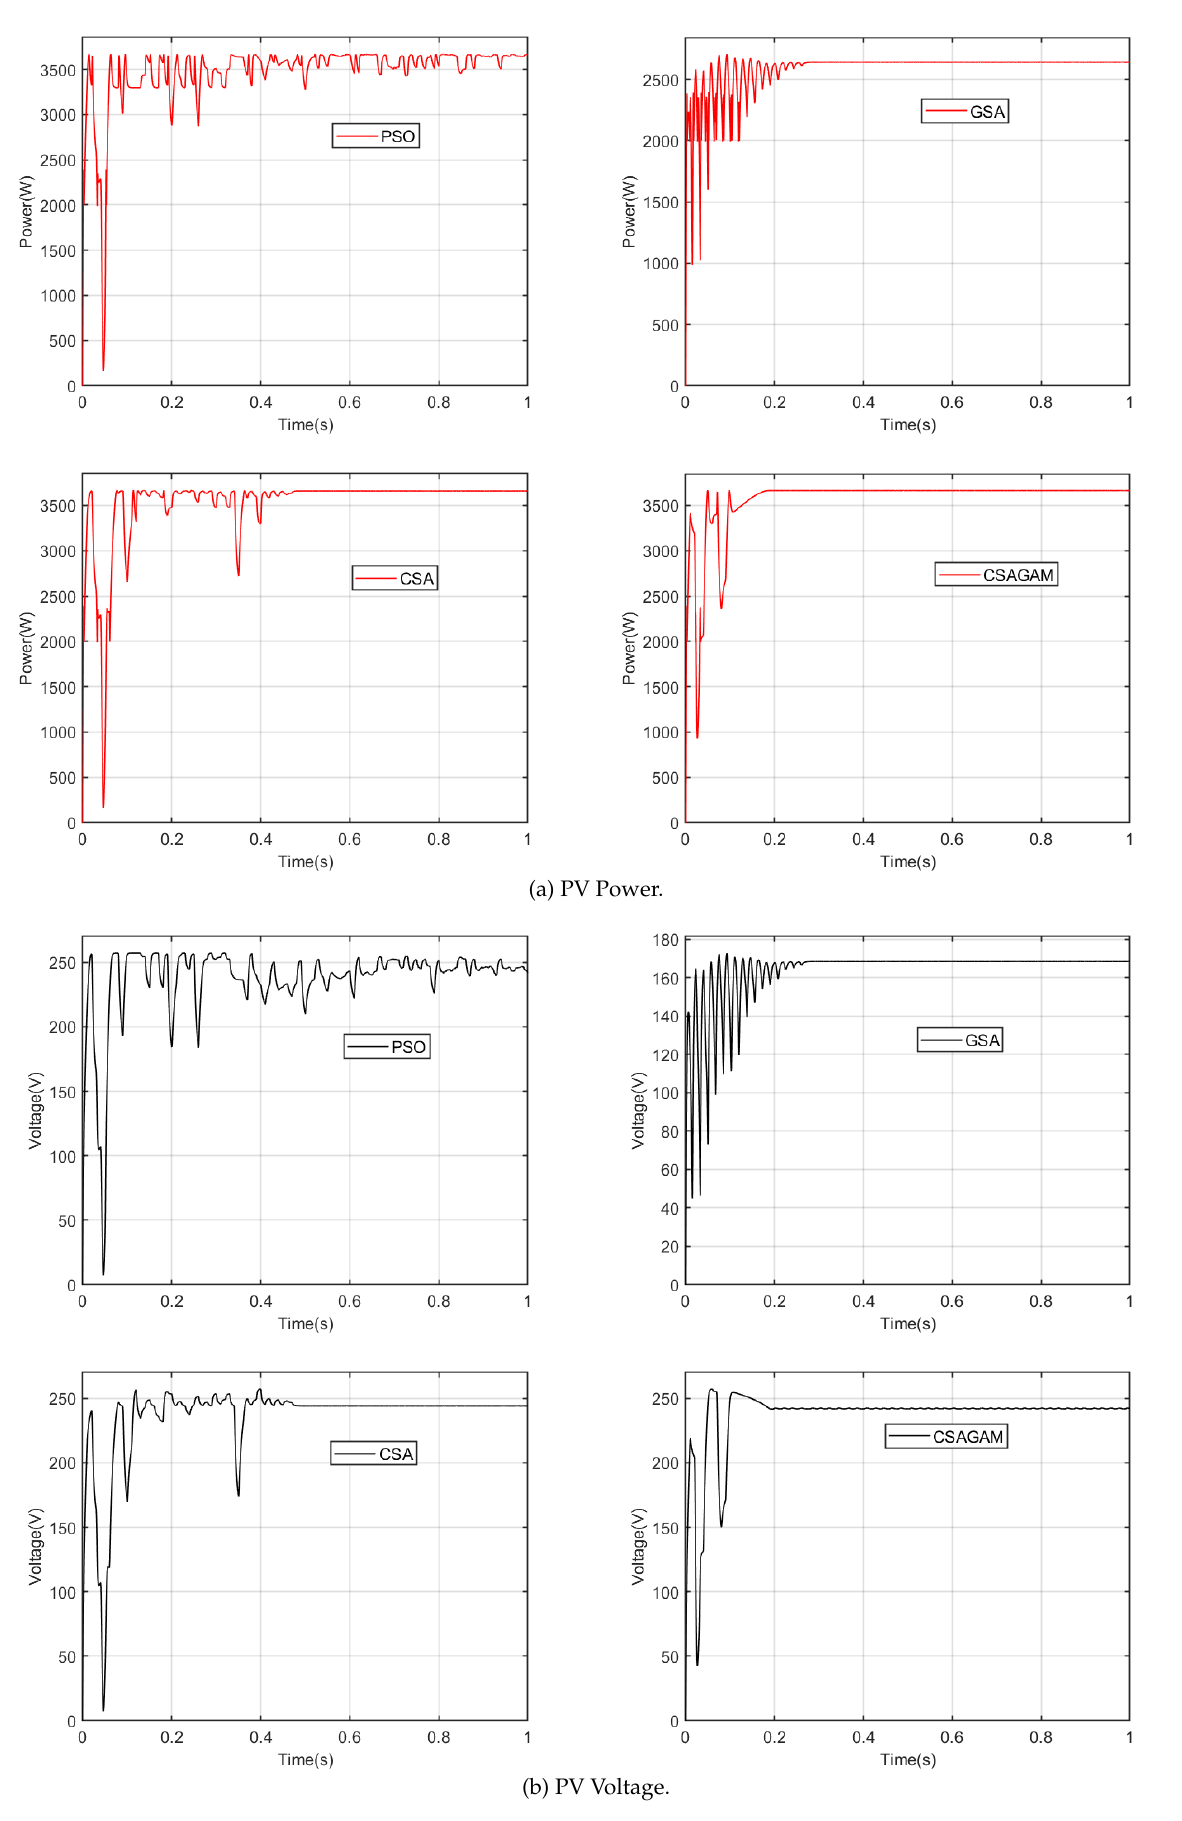
Fig. 7. Simulation results for the first partial shading case PSC